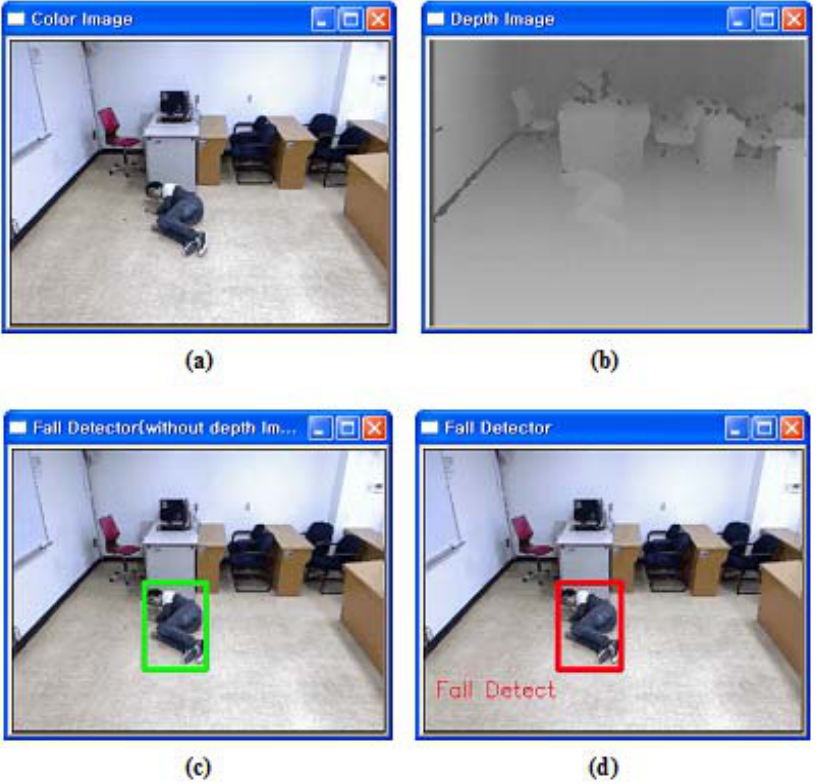
Figure 2. Results of abnormal event detection: ( a ) Original image; ( b ) Depth image corresponding to (a); ( c ) Result with UFED 1 (not detected); ( d ) Result with a combination of UFED 1 and UFED 2